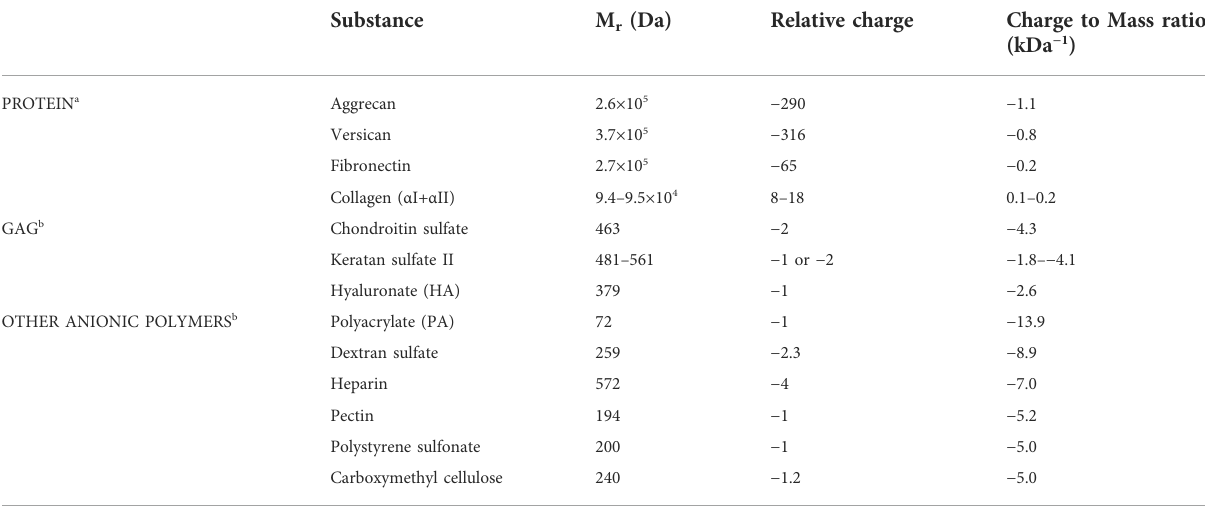
TABLE 1 Comparison of charge to mass ratio for selected macromolecules and